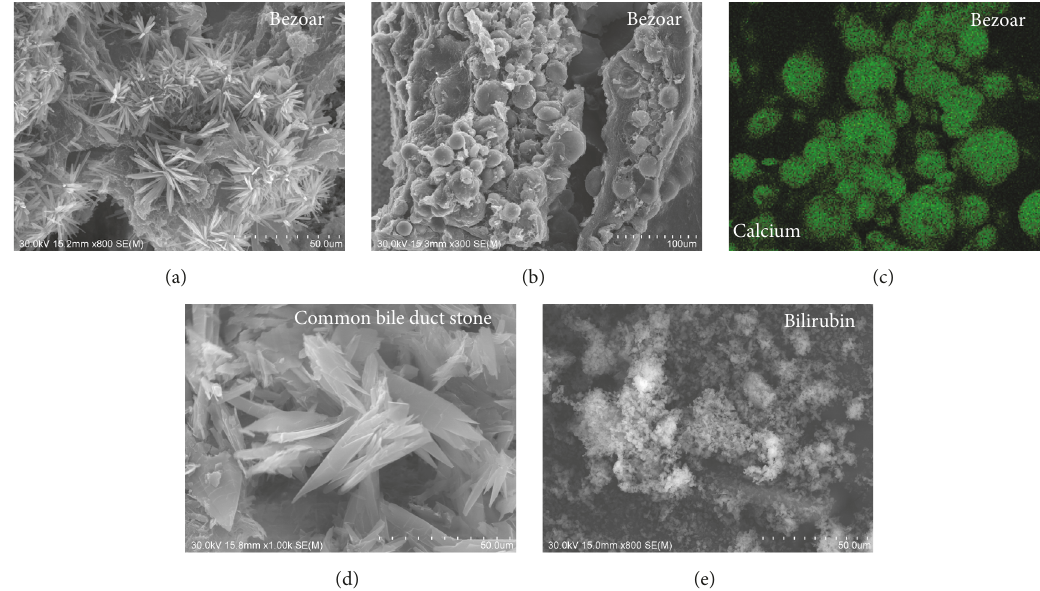
Figure 5: Electron microscopy images. The cut surface of the bezoar showed acicular crystals (a). Multiple globular substances were observed only in the bezoar core (b). Elemental mapping showed a large amount of calcium deposition in the globular substances (c). The common bile duct stones also showed acicular crystals (d). However, the width and length of these stones were greater than those of the bezoar. Crystals were not observed in the commercially available bilirubin powder